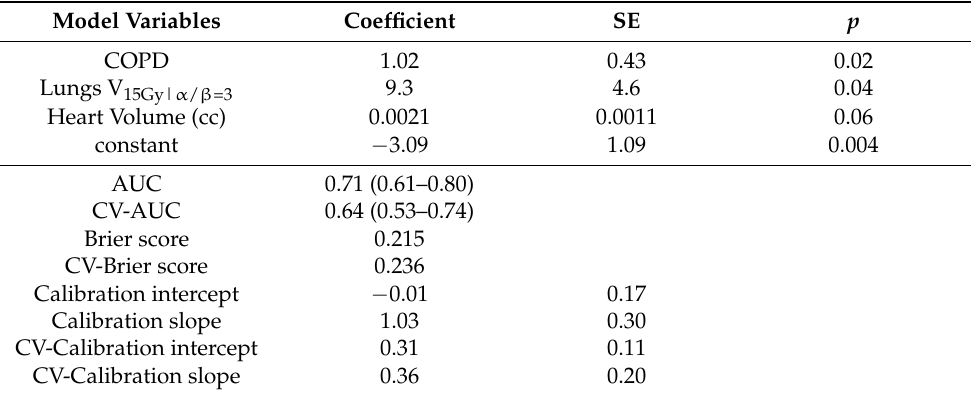
Table 2. Multivariable logistic regression model coefficient and model performance for any grade dyspnea, 95% confidence intervals are in brackets.